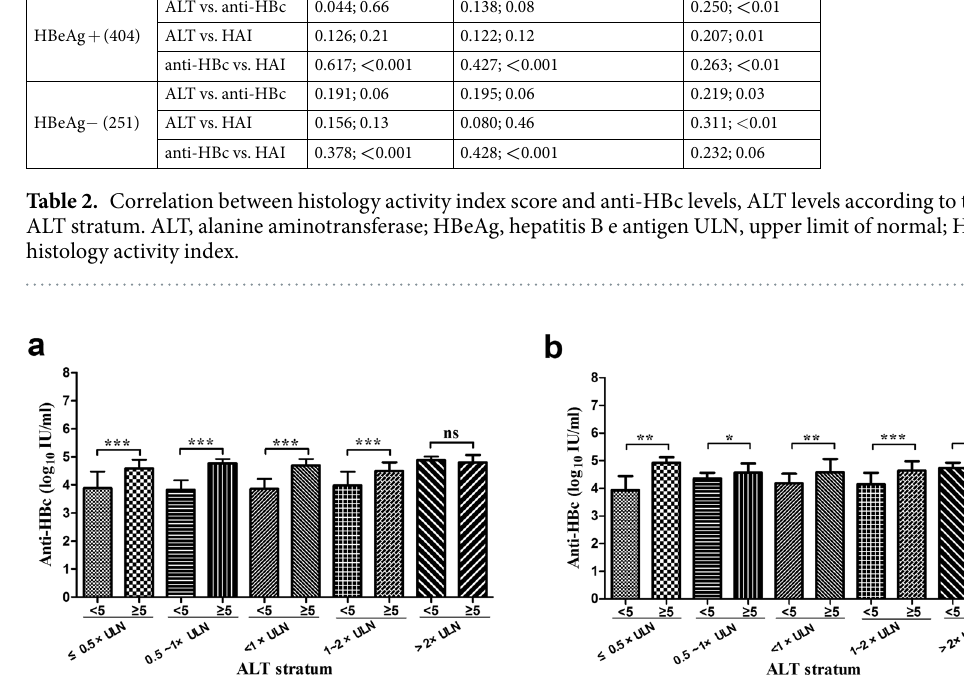
Figure 3. Correlation between Anti-HBc levels and histological scores of activity in HBeAg ( + ) ( a ) and HBeAg ( − ) ( b ), according to the ALT stratum. *** P < 0.001, ** P < 0.01, * P < 0.05 and ns , no significance. Interquartile ranges with medians presented. ALT, alanine aminotransferase; ULN, upper limit of normal; HAI, histology activity